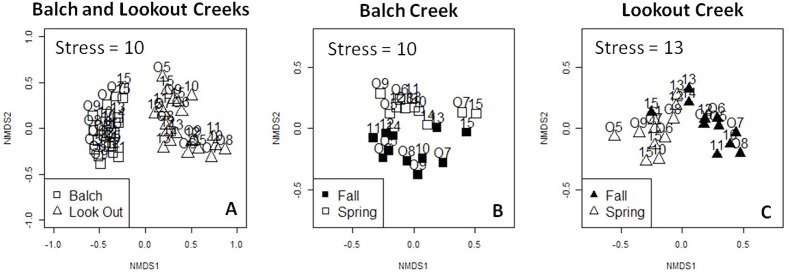
Ordinations for both streams (Panel A), Balch Creek (Panel B) and Lookout Creek (Panel C). Participants generated data for the ordinations by sampling the same reach biannually from 2005–2015. Season is indicated for fall (filled symbol) and spring (open symbol) samples. The two-digit number indicates sampling year.